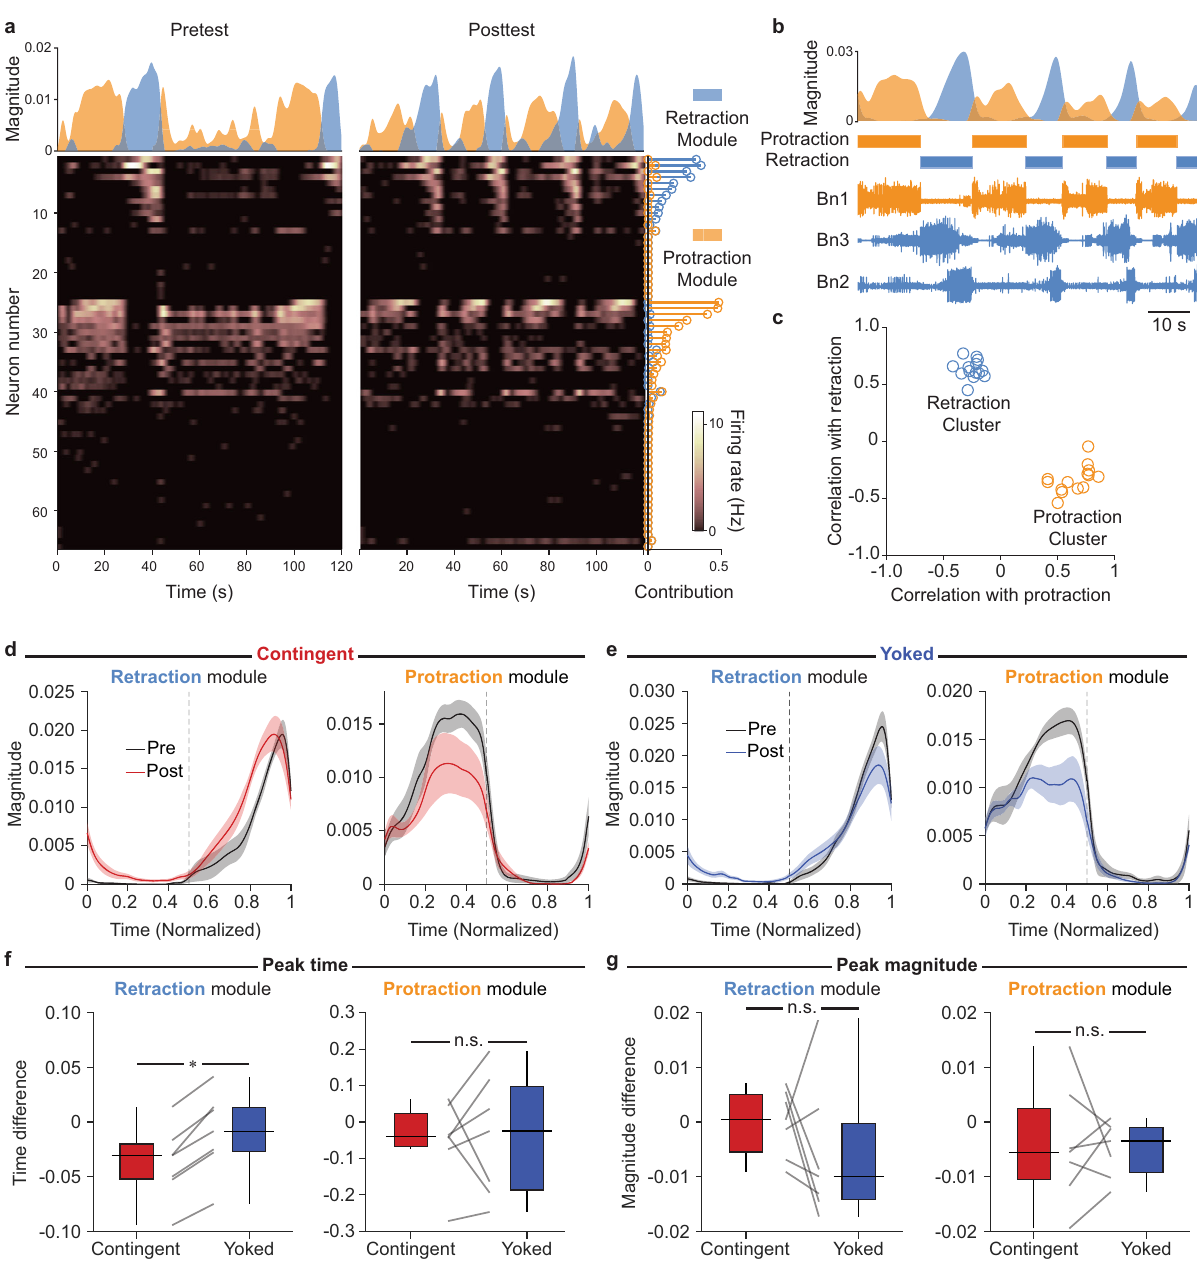
COMMUNICATIONS BIOLOGY| (2022) 5:90